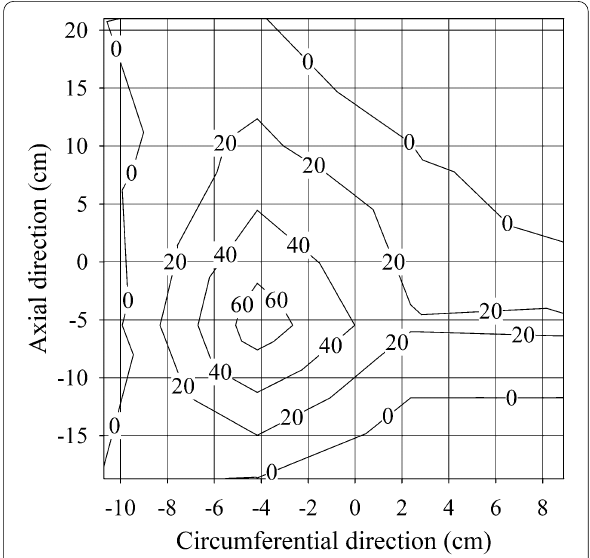
Fig. 2 Distribution of cap 133 Cs concentration of shiitake ( Lentinula edodes ) in bed-log cultivation ( n 16). 133 Cs solution was injected to = a perforation depth of 3.2 cm. The cap 133 Cs concentration (mg/kg) was obtained by subtracting the cap 133 Cs concentration in shiitake